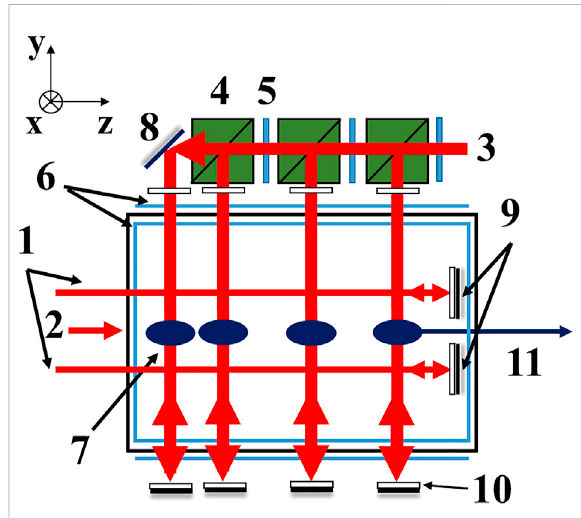
FIGURE 1 Schematic (yz plane) of the cold cesium atomic beam source [16]. 1: Hollow cooling light; 2: Pushing light;3: Transverse cooling light; 4: Polarizing beam splitter prism; 5: λ /2 wave plate; 6: Magnetic fi eld coil; 7: Cold atomic cloud; 8: Re fl ector; 9: λ / 4 wave plate with center 1 mm hole and high re fl ective coating on the back; 10: λ /4 wave plate; 11: Cold cesium atomic beam.